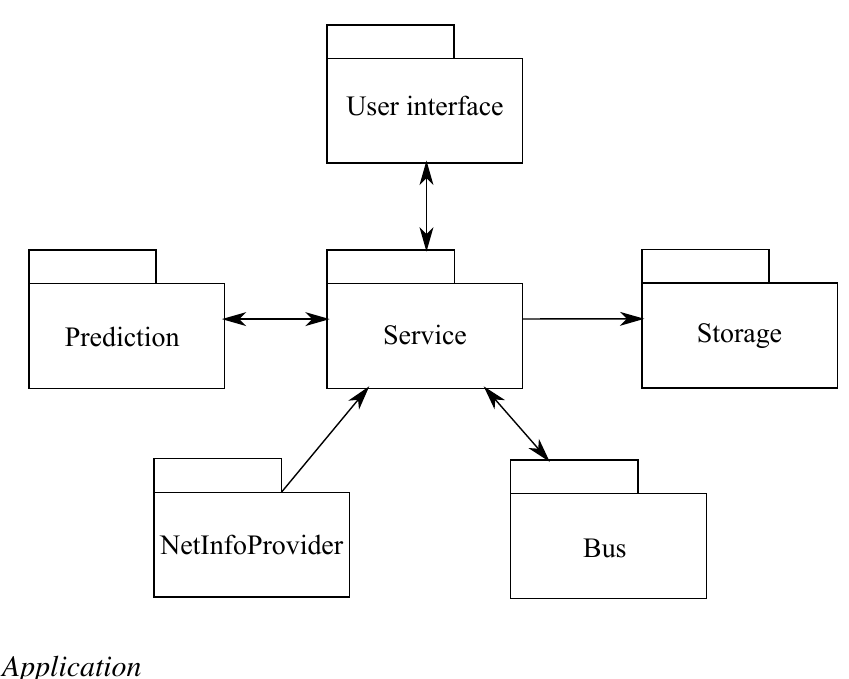
Figure 13. Block diagram of the recommender